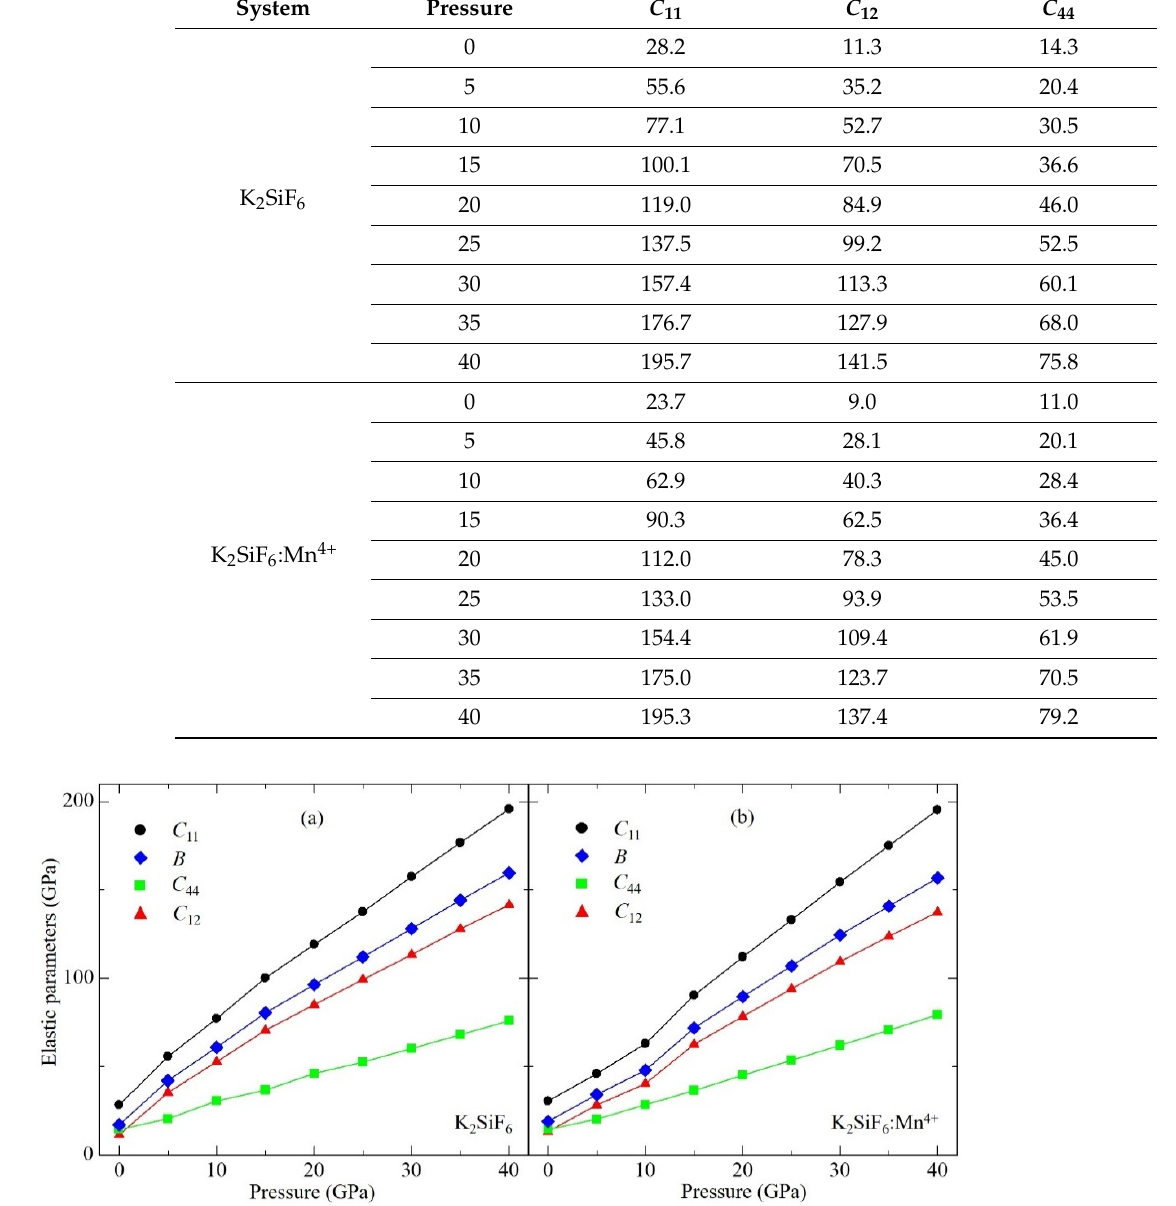
Figure 2. Calculated elastic constants C ij and bulk moduli B for ( a ) non-doped and ( b ) Mn 4+ -doped K 2 SiF 6 as a function of pressure.